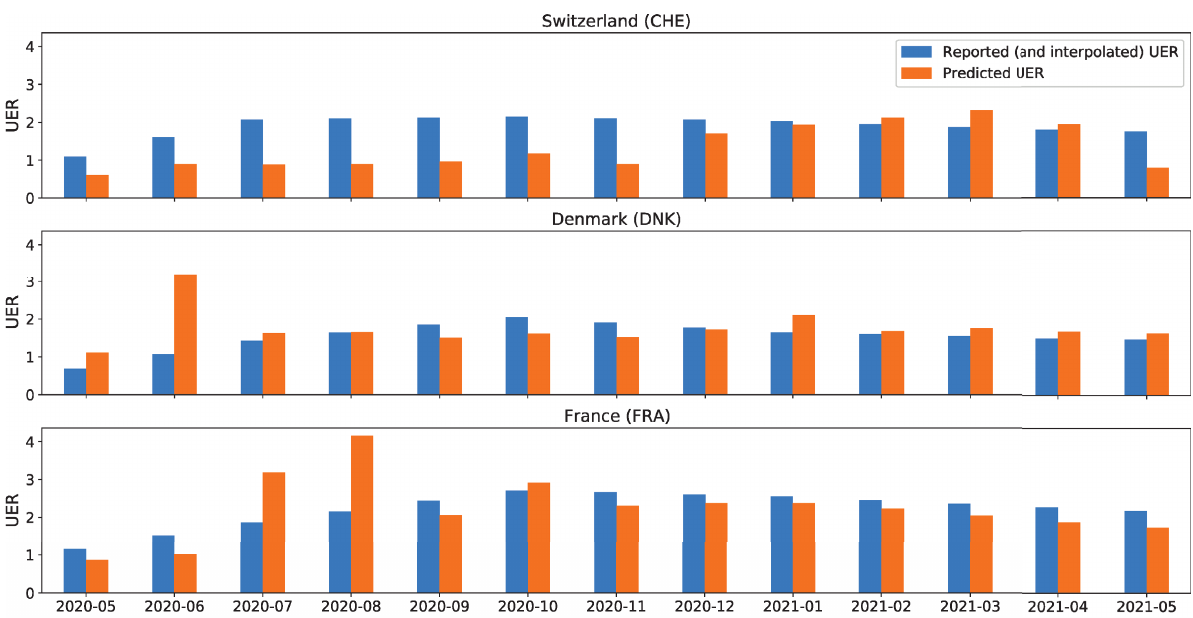
Fig 6. Unemployment rate predictions for three sample countries. Unemployment rate predictions for (top to bottom) Switzerland, Denmark and France. The ground unemployment rate is shown in blue, the predicted unemployment rate in orange.